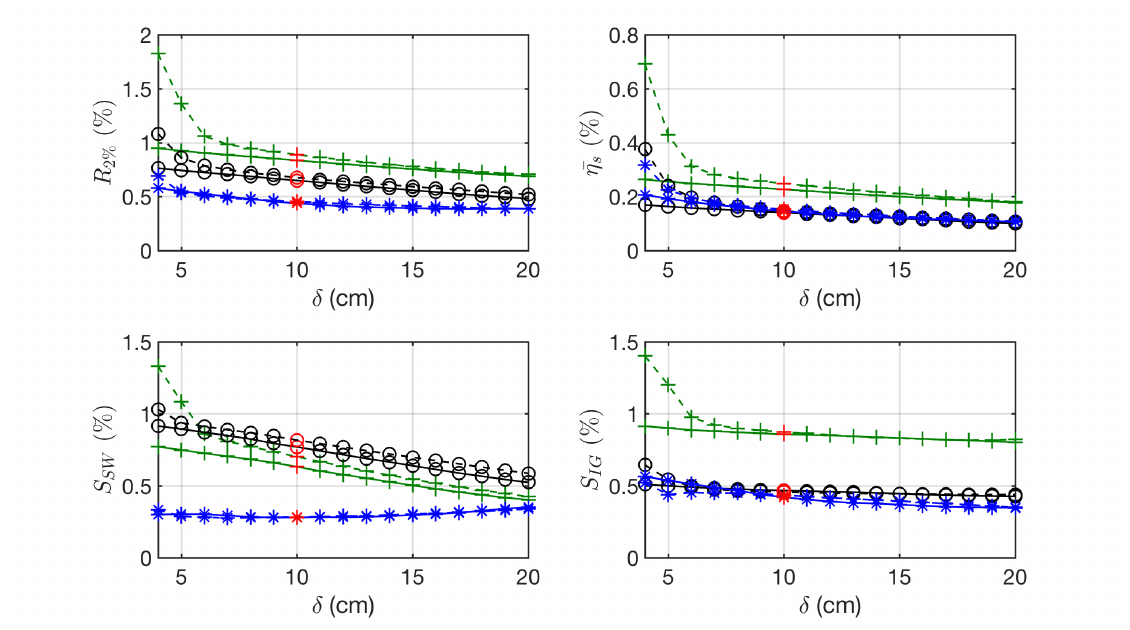
Figure 12. Experimental (dashed line) and numerical (solid line) runup components depending on the threshold depth δ for the DR0 (blue stars), SBE2 (green plus signs), and SBA1 (black circles)